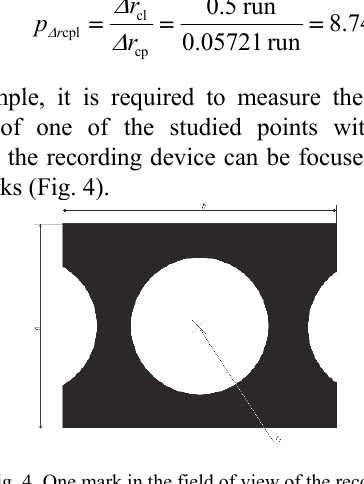
Fig. 4. One mark in the field of view of the recording